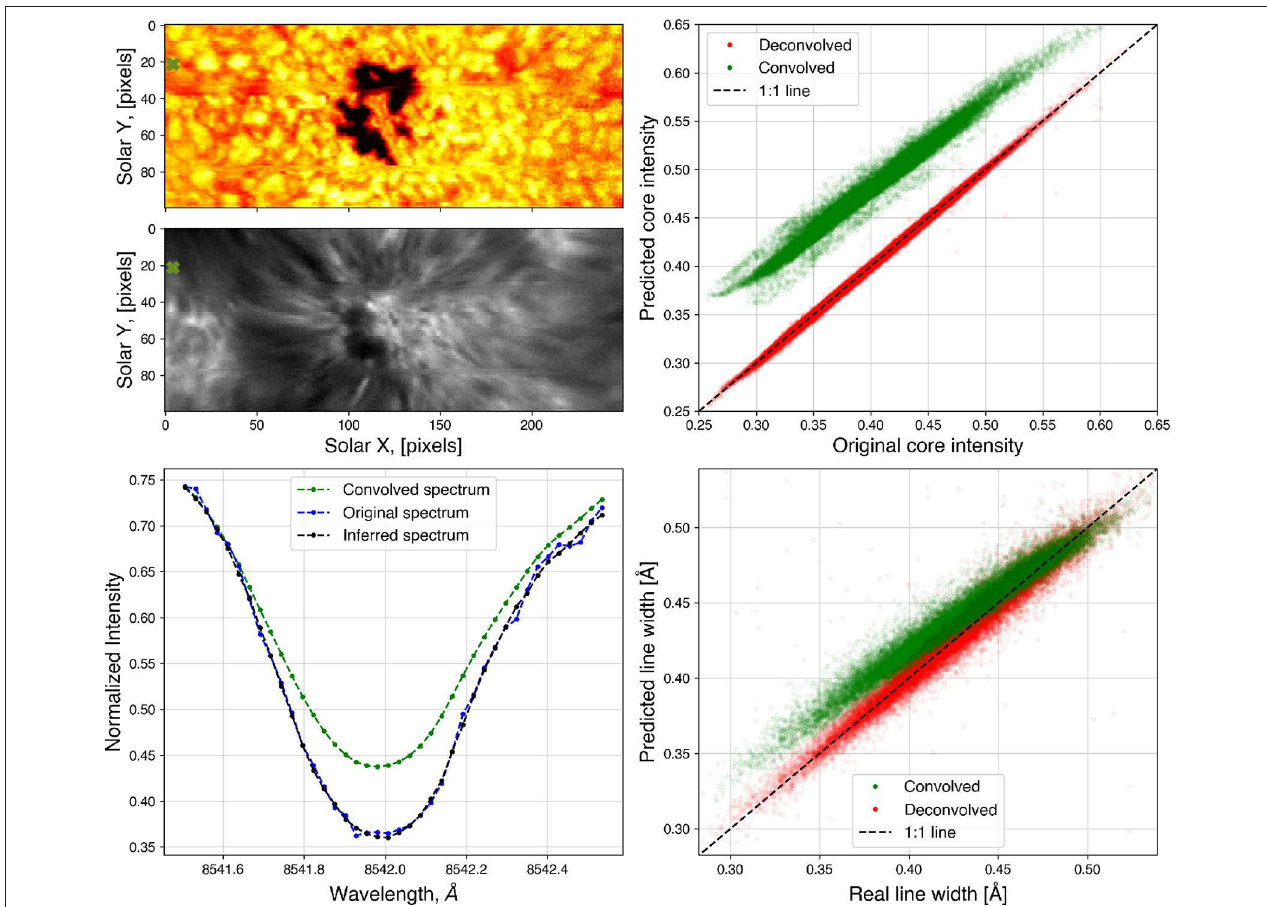
FIGURE 2 | (Top left) Continuum image/Line core intensity of Ca II 8542 Å of the FISS dataset used for the experiment in sections 3.1 and 4; (Bottom left) A sample profile (coordinates [4, 21] in our datacube, green cross in top left panel) shown before convolution with wide SPSF (blue line), after the convolution (green) and after the deconvolution with the CNN (black); (Top right) Comparison of the line core intensity recovered with the algorithm—true line profile (black line is the one-to-one line). The approach for measuring line intensity and width are described in section 3.1. (Bottom right) Same as the previous panel but for the line core width of the Ca II 8,542 Å